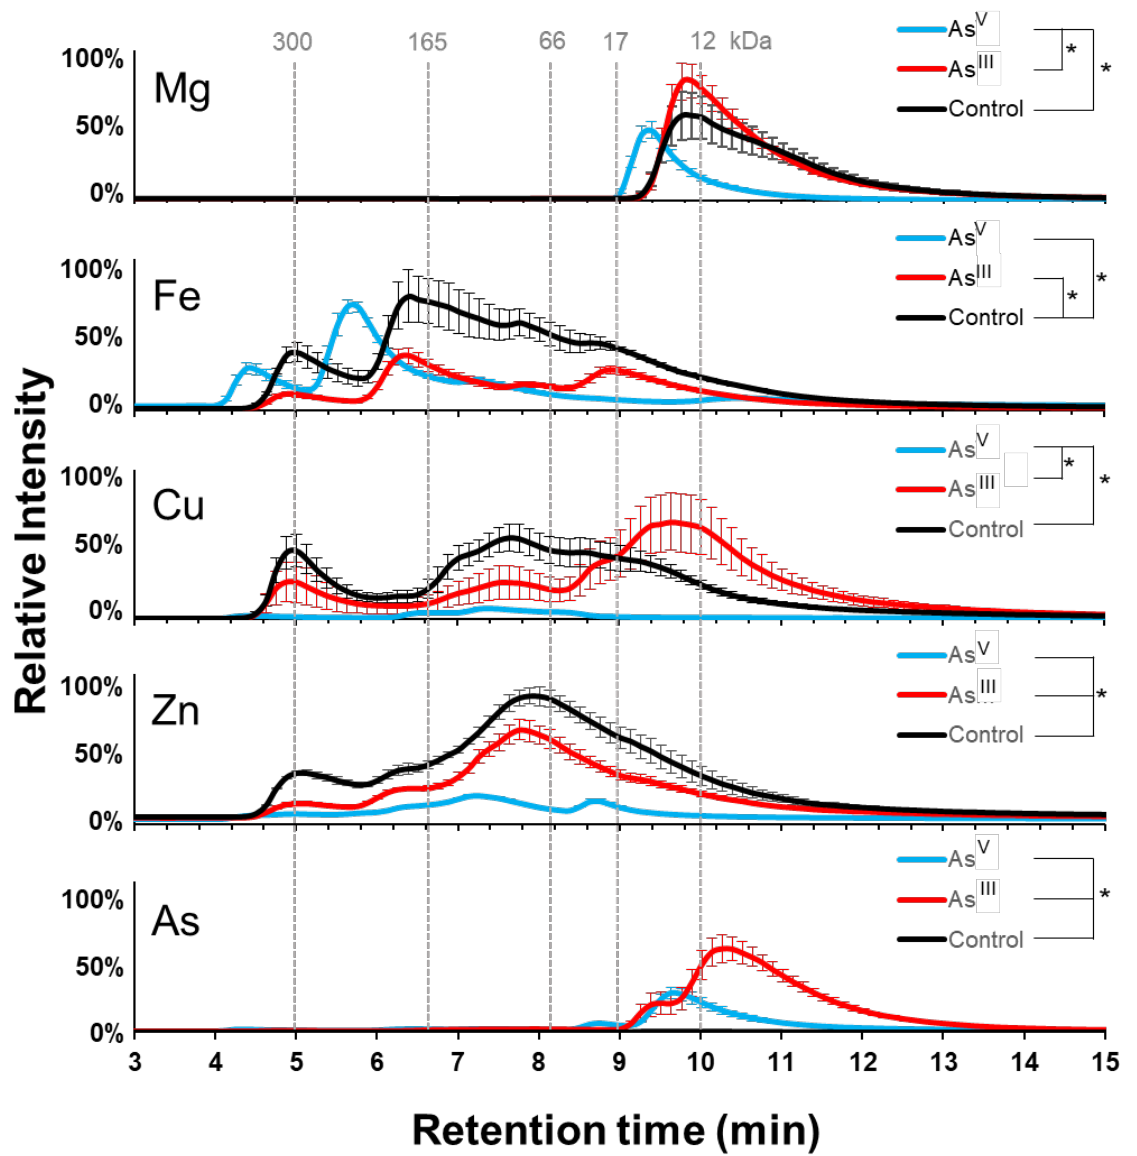
Figure 3. AW3110 Metalloproteome response to arsenic treatment: Metal profiles for copper, mag- nesium, arsenic, iron, and zinc from SEC-ICP-MS analysis. As V treatment is shown in cyan, As III treatment is in red, and control is in black. Error bars are +/ − 1 standard deviation. * Indicates signif- icant differences ( p < 0.05) determined by a S tudent’s t -test (n = 3 for As III and control; n = 4 for A V treatment).